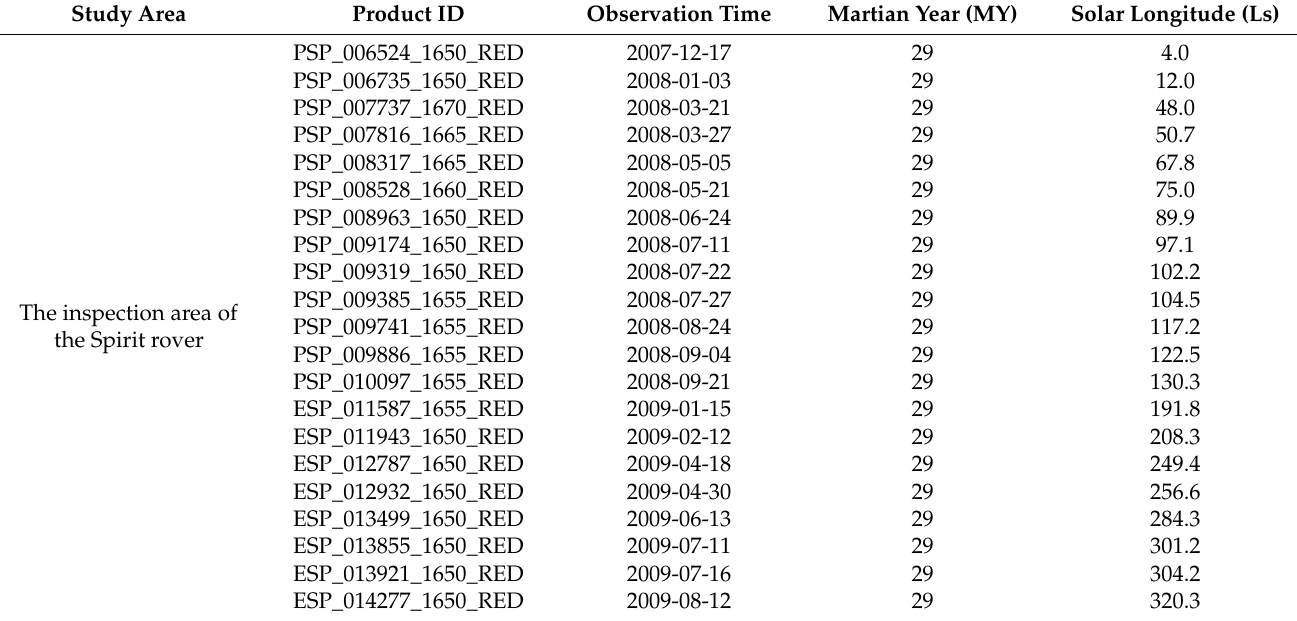
Table 1. List of related High Resolution Imaging Science Experiment (HiRISE) images. Study